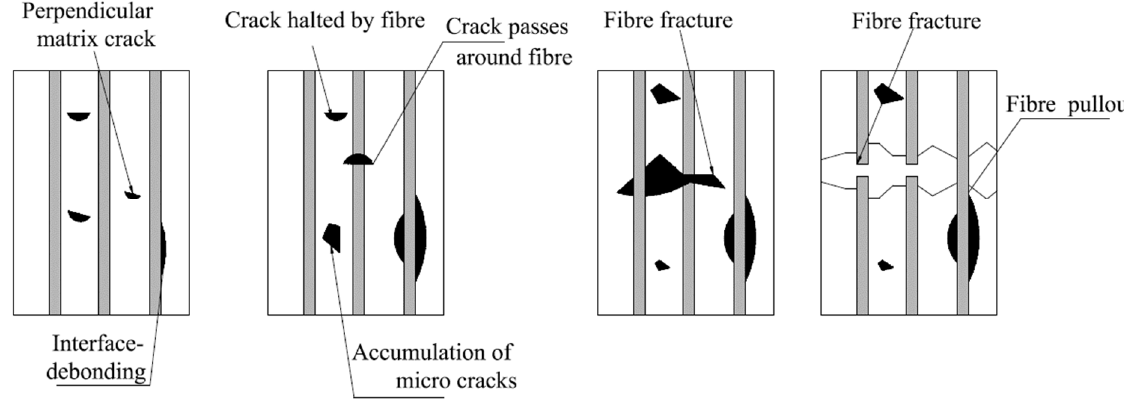
Figure 20. Fiber pull ‐ out and debonding.